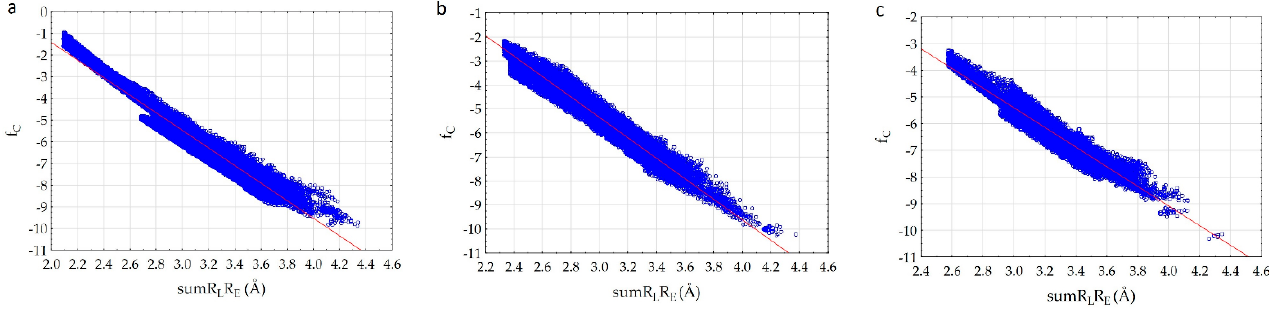
Figure 3. Correlation of the complementarity factor (fc) and the sum of the distances (sumR L R E ): ( a )—7D4F (suramin com- plex), ( b )—7CTT (favipiravir-RTP complex), ( c )—7AAP (favipiravir-RTP complex).